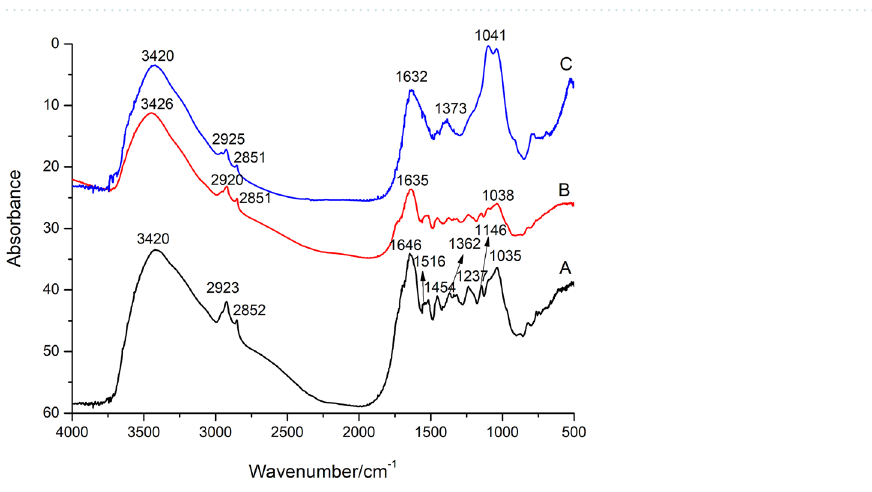
Figure 3. Photographs under microscope of calcium phytoliths from sample CST. ( a ) crack-type calcium phytoliths; ( b ) druse-type calcium phytoliths; ( c ) trichome-type calcium phytoliths.